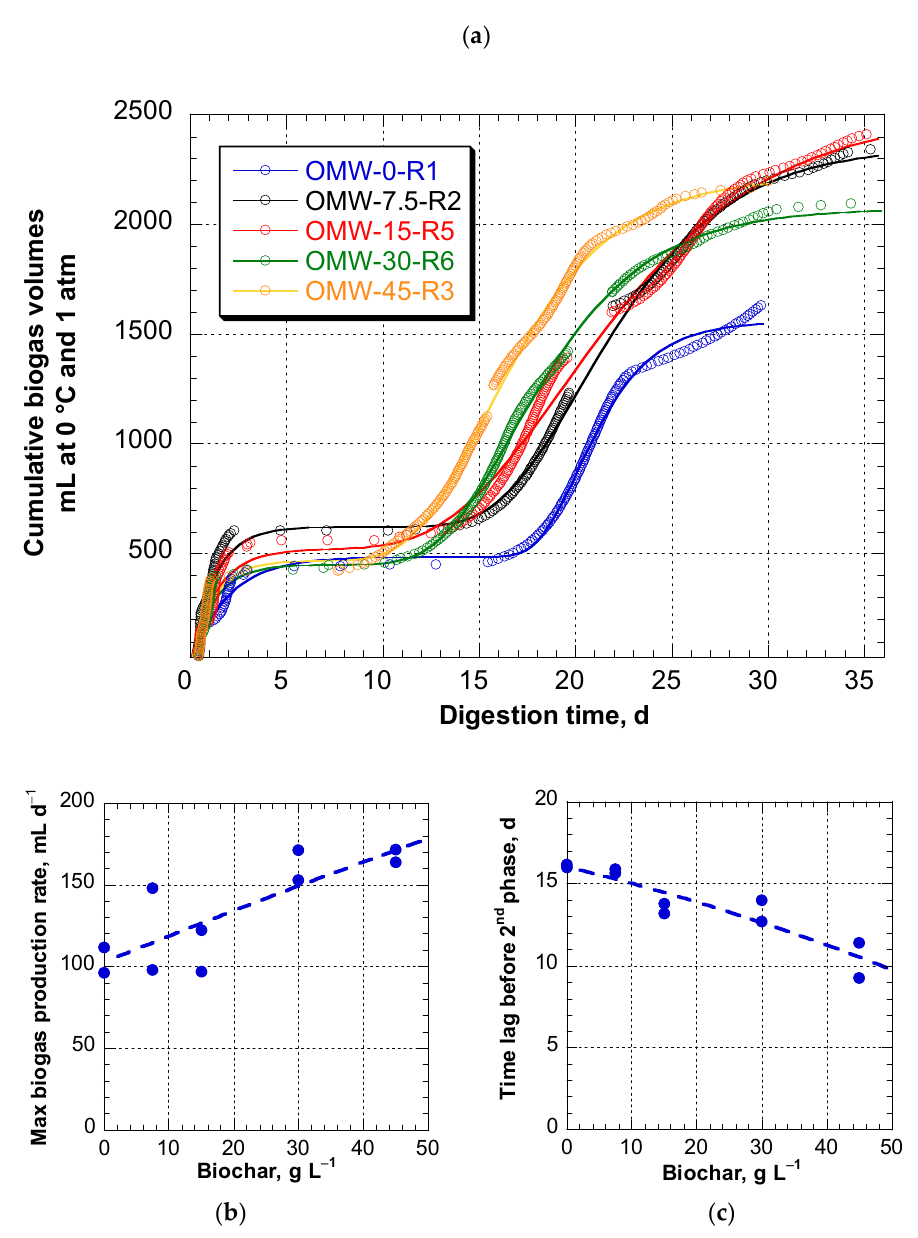
Figure 2. ( a ) Sample fits of biogas production data with the double Gomper model (Equation (2)), only 50% of data points are shown for clarity; ( b ) R estimates versus biochar concentrations; ( c ) λ estimates versus biochar concentrations (dashed lines in ( b , c ) have been drawn to highlight the trends).